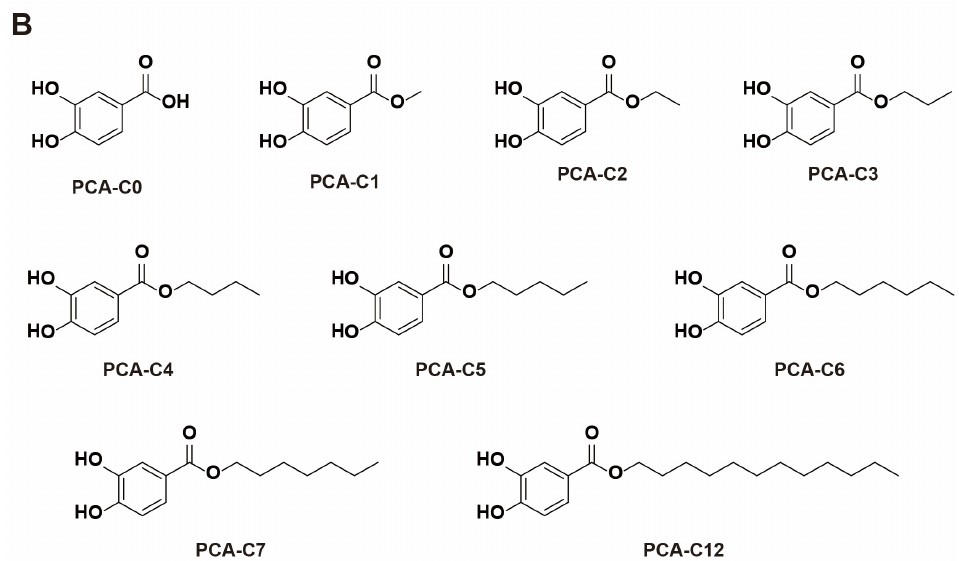
Figure 1. Molecular structures of PCA derivatives. ( A ) Synthetic procedure for alkyl ester derivatives of PCA. ( B ) A series of PCA derivatives: PCA-C0–C7 and C12.